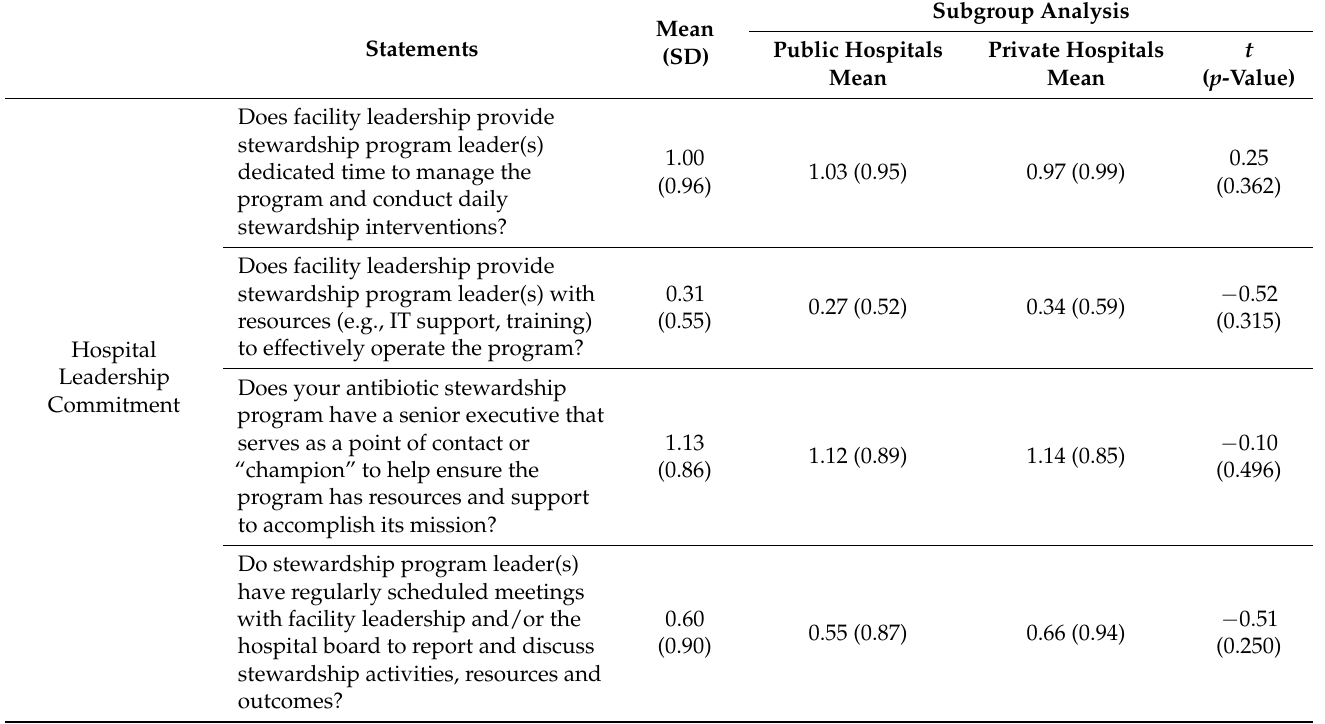
Table 3. Item level analysis of core elements of antibiotics stewardship